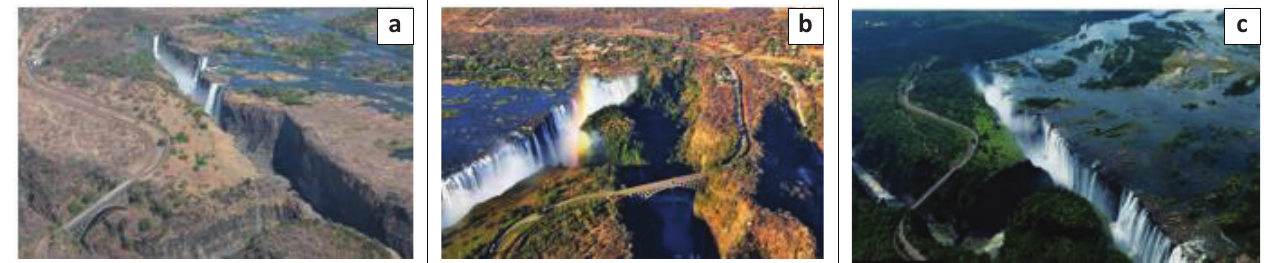
FIGURE 8: Respondents’ perceptions on the scene they like to see most at Victoria Falls (a–c).